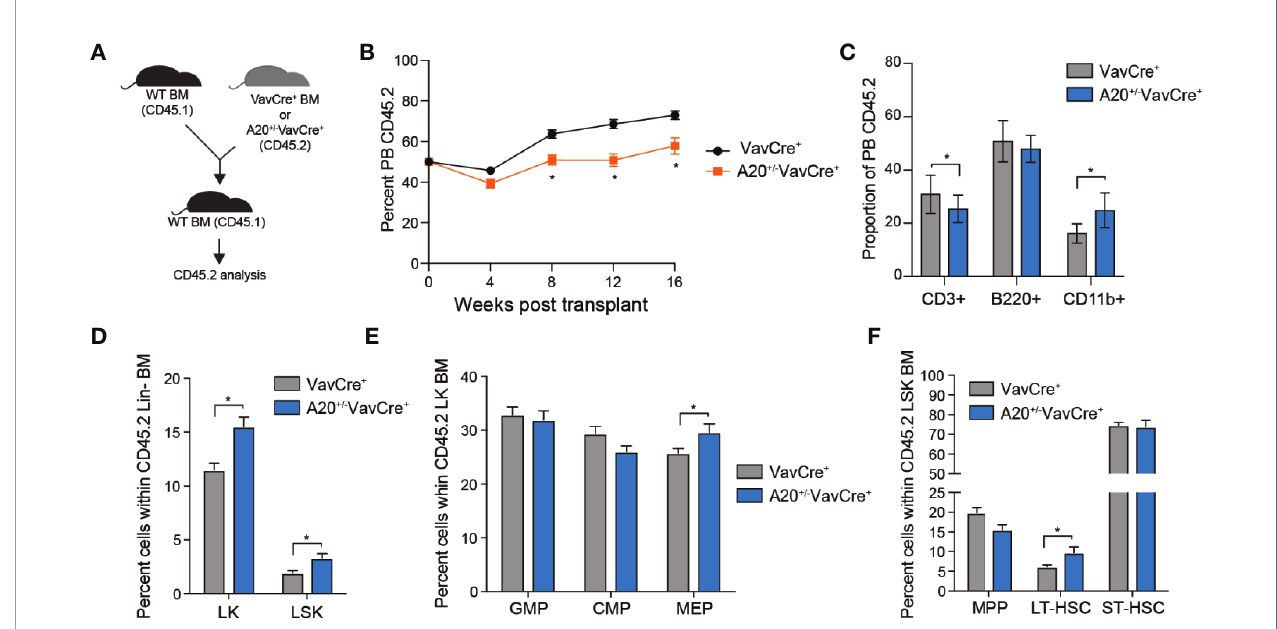
FIGURE 4 | Heterozygous deletion of A20 results in a competitive advantage of hematopoietic stem and progenitor cells. (A) Outline of competitive BM transplantations using VavCre + or A20 +/- VavCre + mice. (B) Summary of donor-derived PB proportions at the indicated time points after competitive transplantation using VavCre + or A20 +/- VavCre + BM cells (n = 10 per group). (C) Proportion of donor-derived VavCre + or A20 +/- VavCre + myeloid (CD11b + ) and lymphoid (CD3 + and B220 + ) proportions at 16 weeks following competitive transplantation (n = 9 per group). (D-F) Summary of donor-derived BM HSPC proportions at 16 weeks after competitive transplantation using VavCre + or A20 +/- VavCre + BM cells (n = 9 per group). *P < 0.05. Data are represented as mean ±